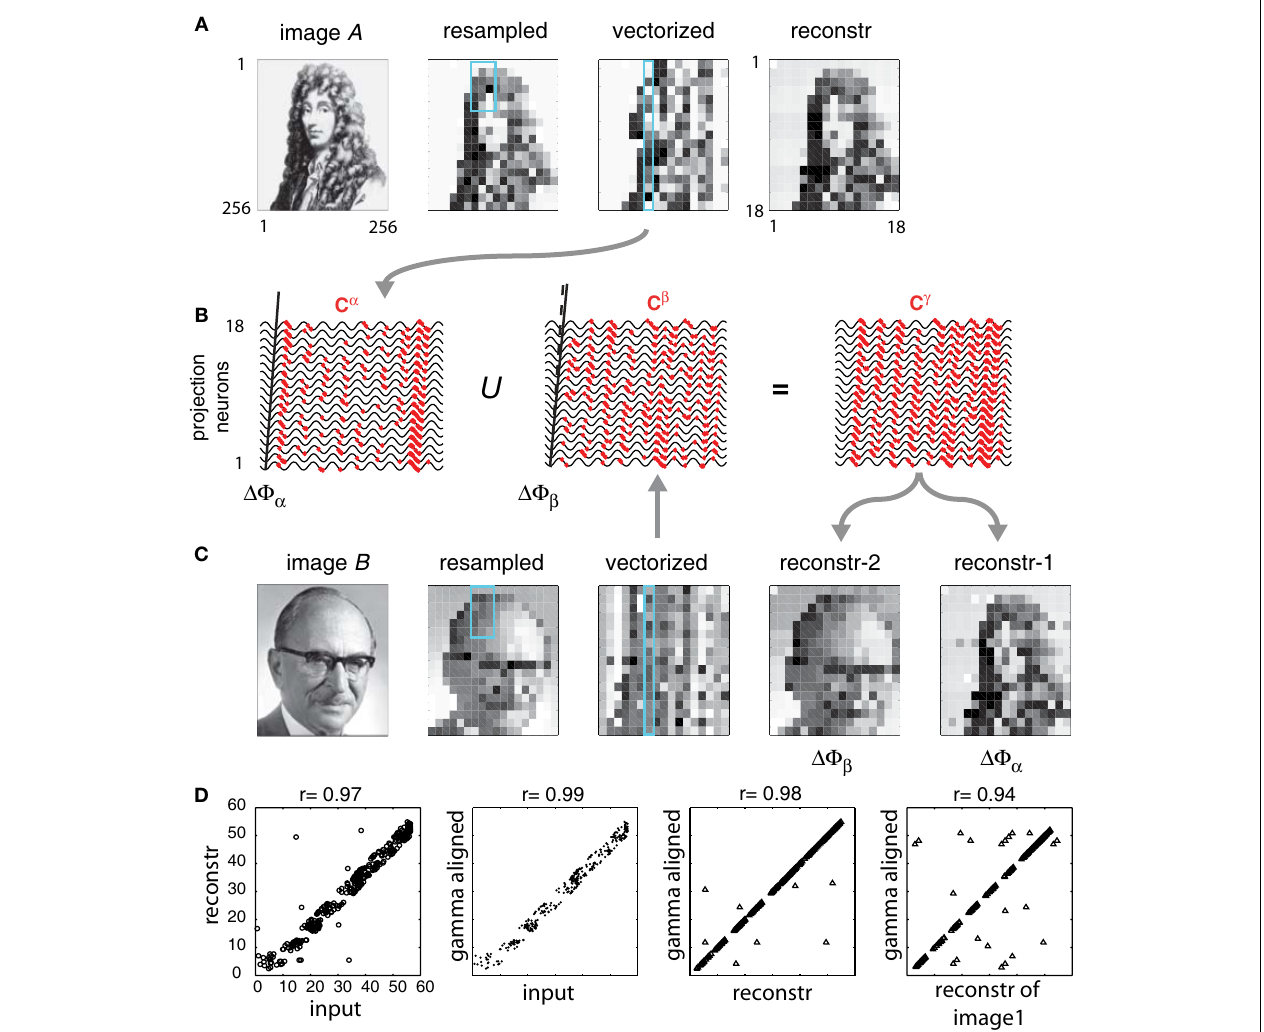
FIGURE 5 | Reconstruction of individual images from combined represents the phase code of APs derived from image A projected on the SMO representations. (A,C) Two different images were digitally sampled at 18 × 18 fi eld. The middle panel represents the same, derived from image B . The right pixel resolution and grayscales were encoded by AP phases relative to SMO panel represents the result after combining the two codes into one. This fi eld by using slightly different phase gradients ΔΦ for image A and ΔΦ for compressed AP sequence is transferred to the site of reconstruction. The last A B image B . The third panel represents the projection of input on a non- two images on (C) represent the reconstruction from the combined code with topographically organized array of neurons. The fourth panel is the reconstruction using ΔΦ vs. ΔΦ . (D) Correlations between: input image B and its A B when only image A was applied. The receptive fi eld was a 3 × 6 rectangle. reconstruction from the combined code; input image B and SMO aligned pattern Turquoise rectangles highlight the projection of a receptive fi eld on the neurons. B ′ ; the SMO aligned pattern B ′ and reconstruction of image B from the (B) APs collected from a single receptive fi eld were collapsed into a single combined code; and the SMO aligned pattern A ′ and reconstruction of image A stream and processed by one of the 18 projection neurons. The left panel from the combined